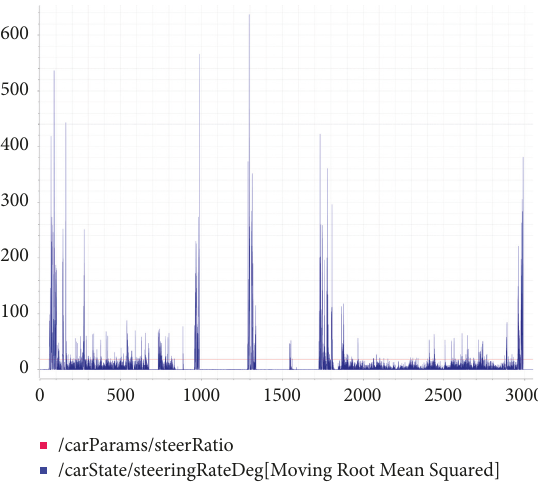
Figure 37: T1N2 steering degrees.